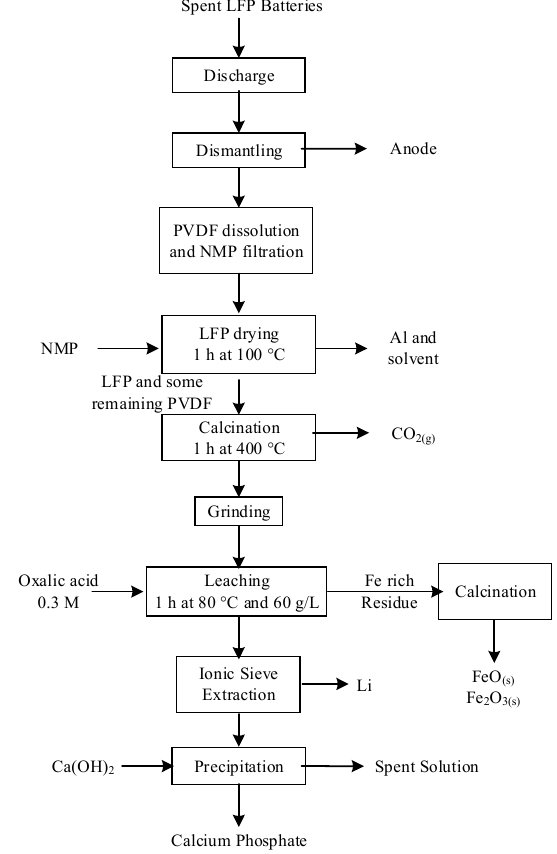
Figure 16. LFP dissolution process proposed by Li et al. (according to [207]); here, LFP, PVDF, and NMP are LiFePO 4 , polyvinylidene fluoride, and N-methyl-2-pyrrolidone, respectively.